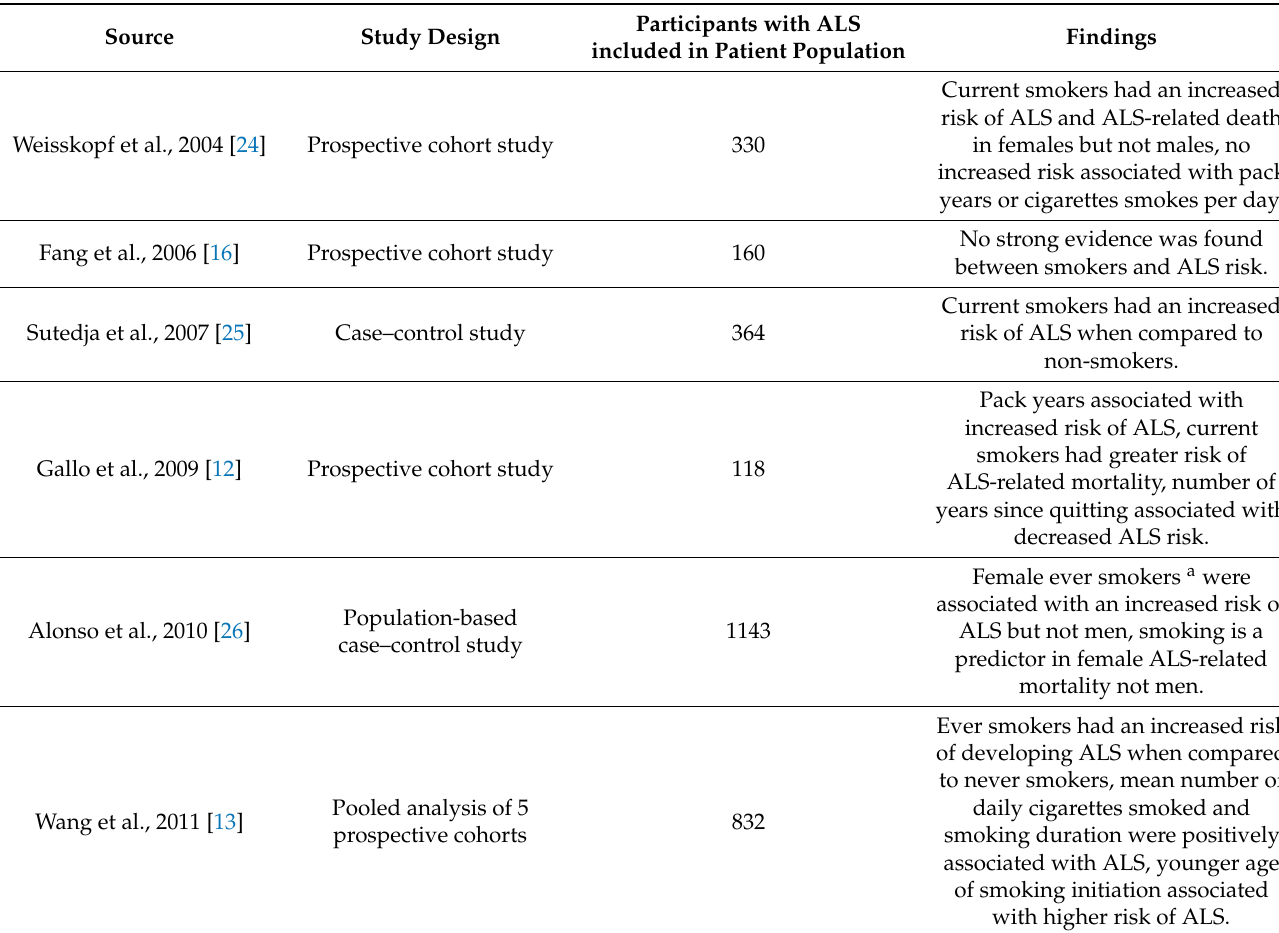
Table 1. Epidemiological evidence regarding the association between cigarette smoking and amyotrophic lateral sclerosis (ALS).